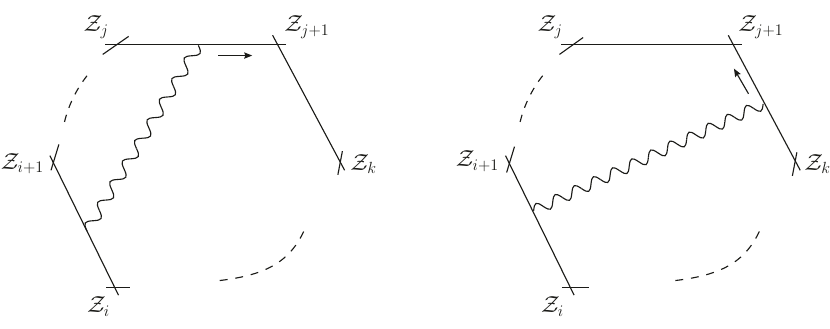
Figure 5 . Spurious poles occur when the propagator end reaches the vertex. It is cancelled by the adjacent diagram. Imposing that this cancellation has a corresponding geometric meaning as a matching of spurious boundaries imposes a correlation between the sign choices for the geometric image of the two